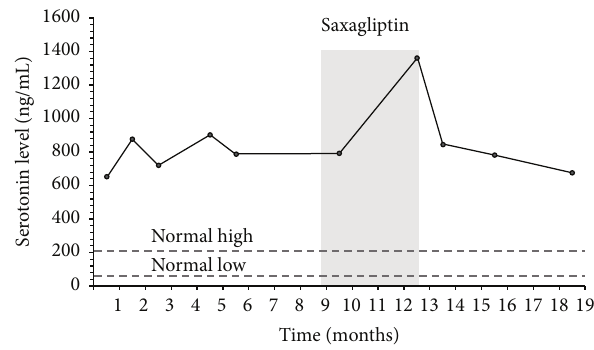
Figure 1: Serotonin level profile (axis 𝑌 ) over period of 19 months. Serotonin level has been stable for several years (last 9 months before initiation of saxagliptin is shown in the figure). 3.5 months after initiation of saxagliptin, serotonin level almost doubled but returned back to baseline within 4 weeks after discontinuation of the treatment. Solid black line represents the patient’s serotonin level. Horizontal dashed gray lines represent normal serotonin serumconcentrations.Grayedareaindicatestheframeofsaxagliptin